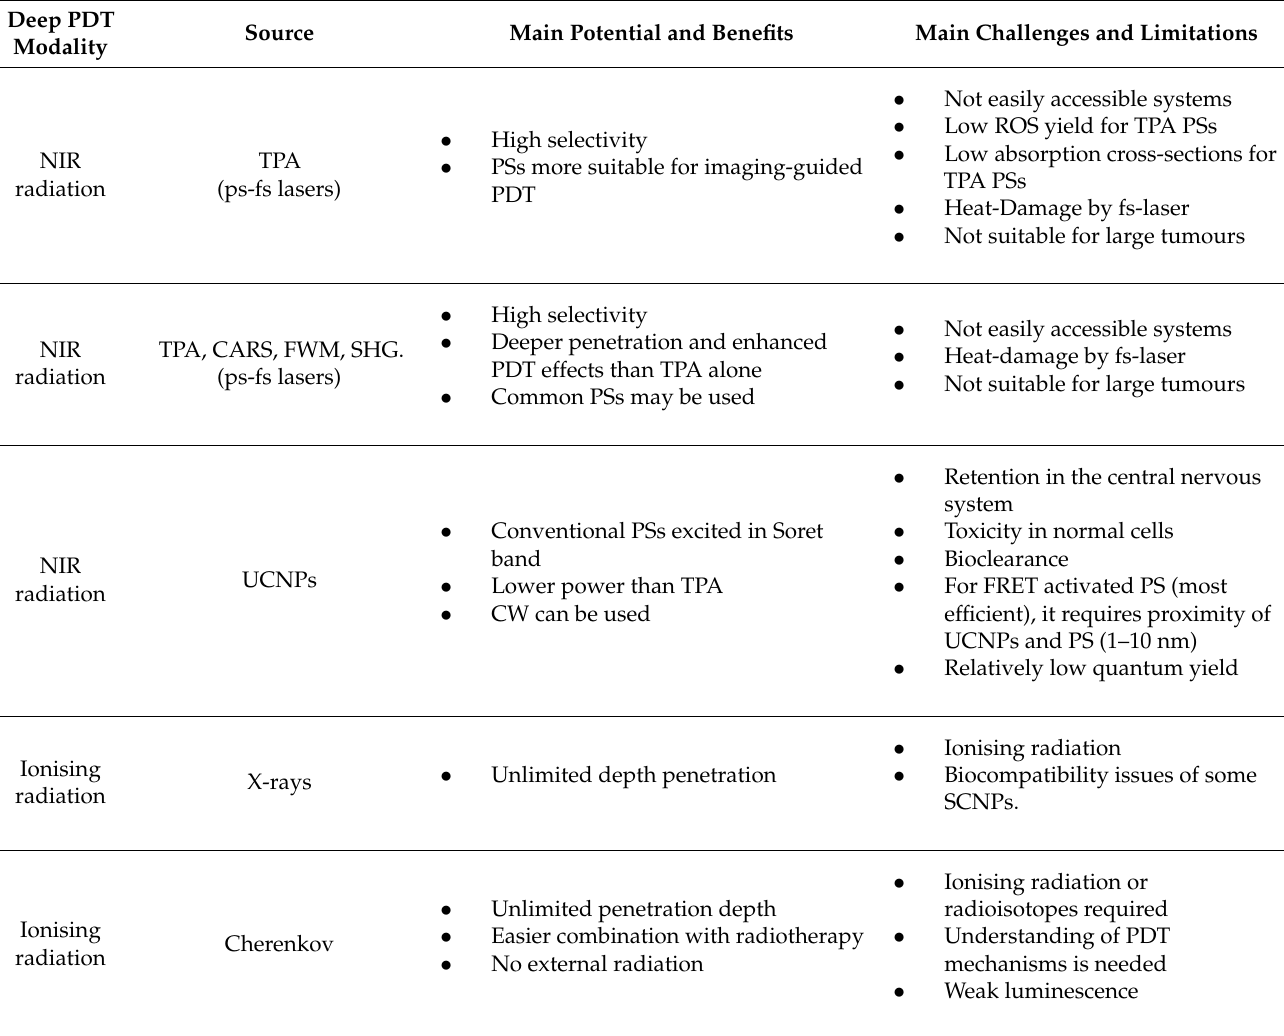
Table 6. Main features and challenges of deep PDT modalities and sources. Only TPA uses direct excitation of the PS whereas all the other deep PDT modalities excite the PS